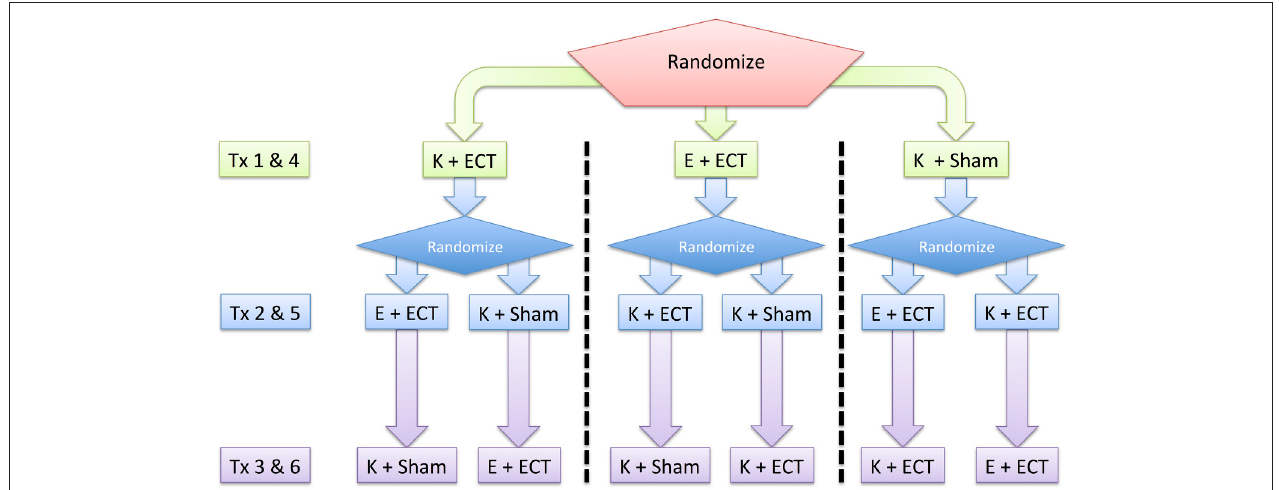
FIGURE 1 | Overall study design. Patients are randomized to repeated testing on three different treatment (Tx) interventions: Etomidate + ECT (E + ECT), ketamine + ECT (K + ECT), and ketamine + sham ECT (K + Sham). These interventions occur over a 2-week period following a dose-charge titration session that determines the adequate ECT charge for treatment-resistant